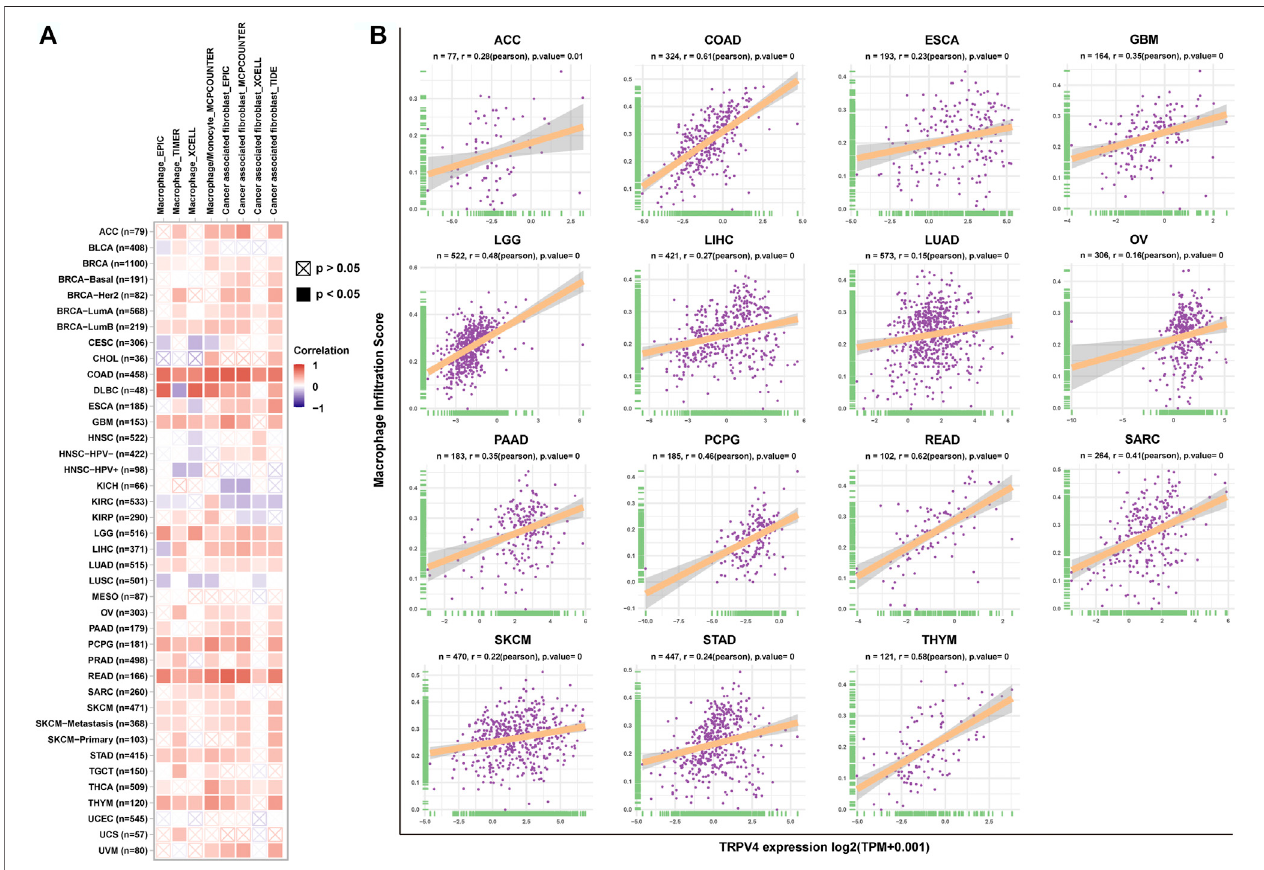
FIGURE6| Immunecellin fi ltrationanalysis. (A) ThecorrelationbetweenTRPV4expressionandTAMandCAFin fi ltrationlevelsinTCGApan-cancersamplesusing theTIMER2database. (B) ThecorrelationbetweenTRPV4expressionandTAMin fi ltrationlevelsinTCGApan-cancersamplesusingdatafromtheImmuCellAIdatabase. The pearson ’ s correlation coef fi cient was calculated using R